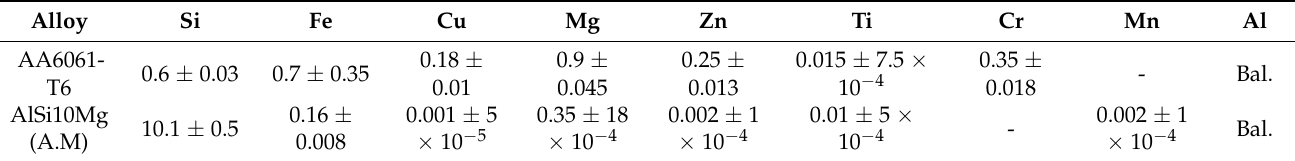
Table 1. Chemical composition of the used aluminum alloys (wt.